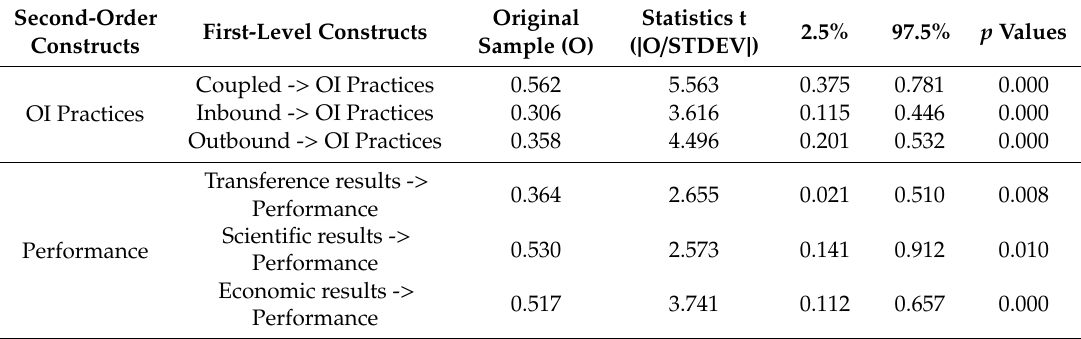
Table 10. Relationships among variables in second order constructs.